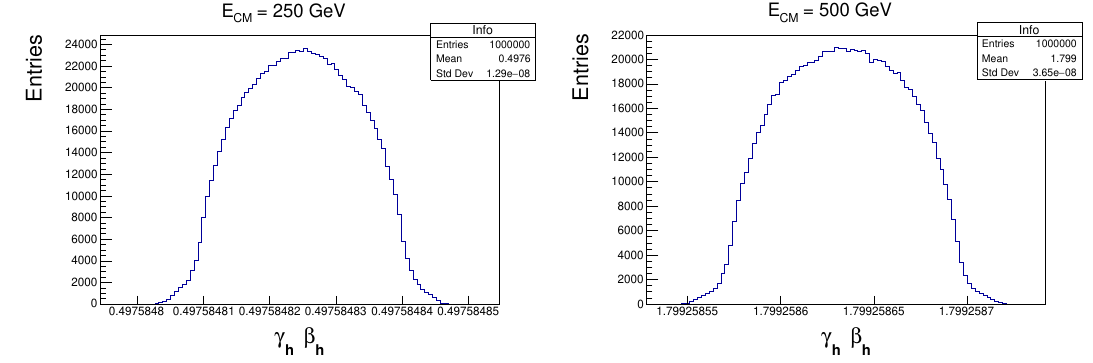
√ s = 250 GeV; right